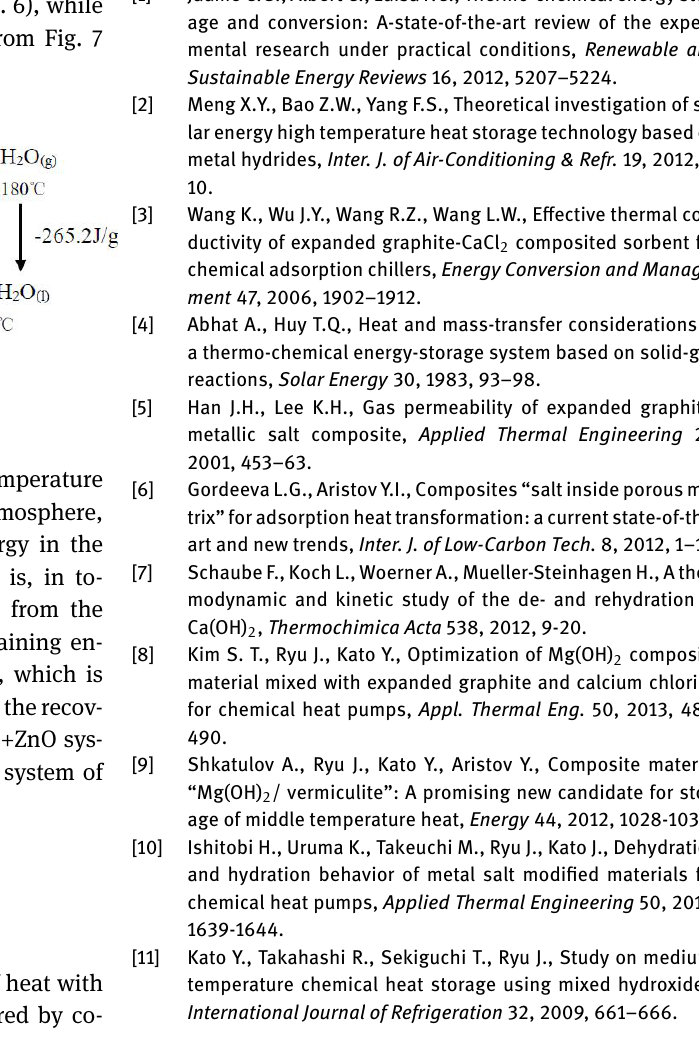
found to be some 300 ∘ lower than that of the bulk hydrox- ides. The optimal thermal storage capacity was achieved for a chemical content parameter α (for Ca 2− α Zn α (OH) 4 ) of 0.8555. The DSC analysis indicated that the correspond- ing thermal storage capacity is 764.5 J/g. The actual re- covery of the stored heat energy for the decomposition of Ca 2− α Zn α (OH) 4 was 63.25%, which is higher than that for the decomposition of Ca(OH) 2 into CaO+H 2 O. Further study on the new nano-composite material is warranted to better understand the mechanism of the decomposi- tion temperature reduction, which may lead to further en- hancement of the heat storage